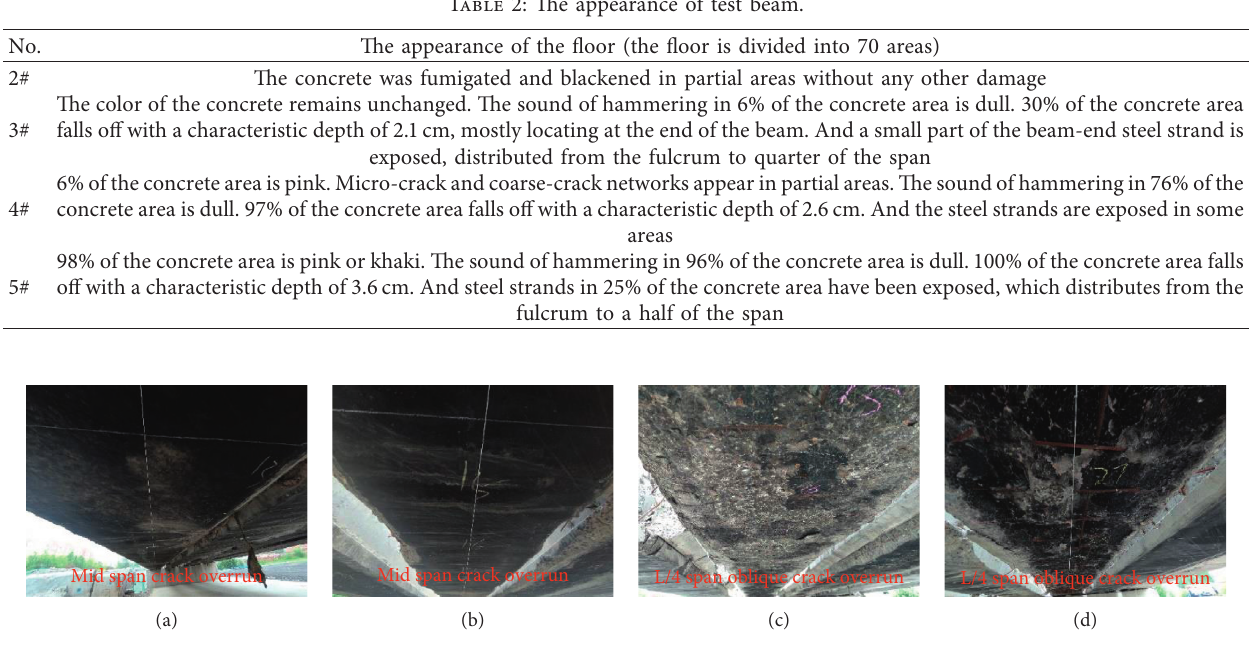
Figure 2: The appearance of test beam. (a) No. 2#. (b) No. 3#. (c) No. 4#. (d) No. 5#.